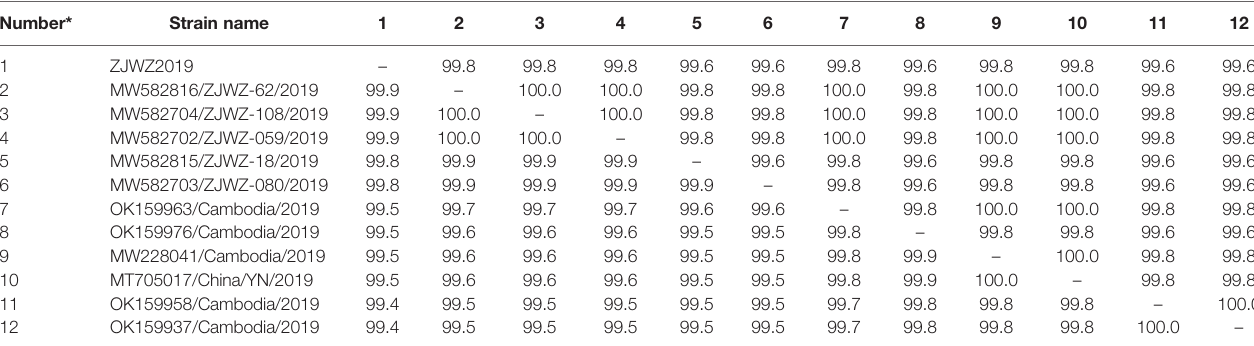
TABLE 3 | Comparison of nucleotide and amino acid homologies of the E gene between ZJWZ2019 and the reference strain (%).